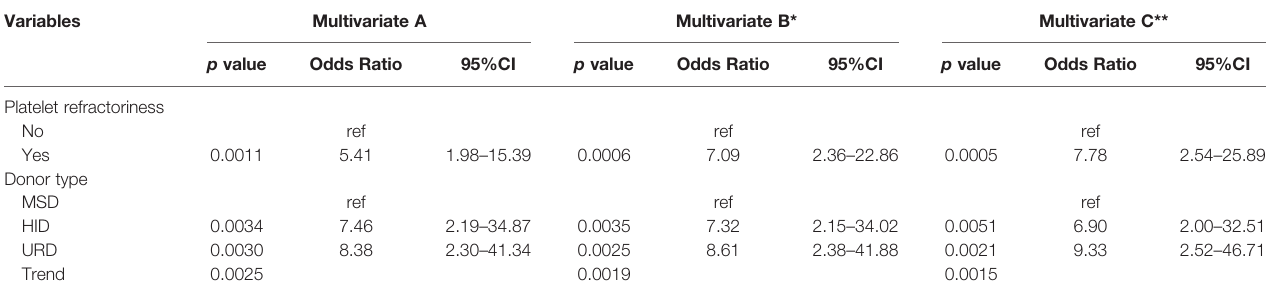
TABLE 4 | Multivariable logistic regression analysis of risk factors for CMVR.